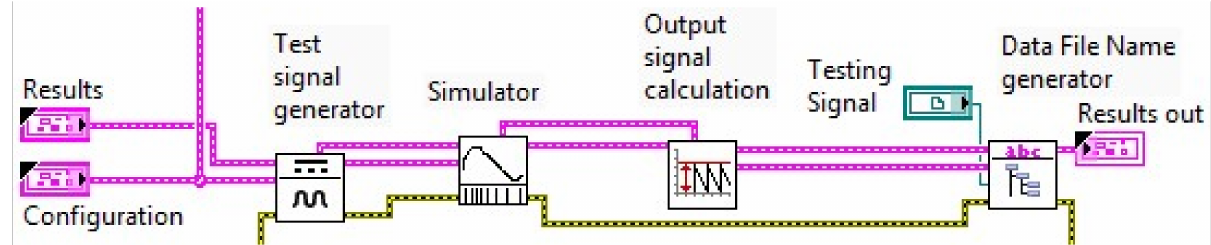
Figure 10. The fragment of the diagram showing the implementation of the simulation process, recreating the input waveform and creating a unique name for the data